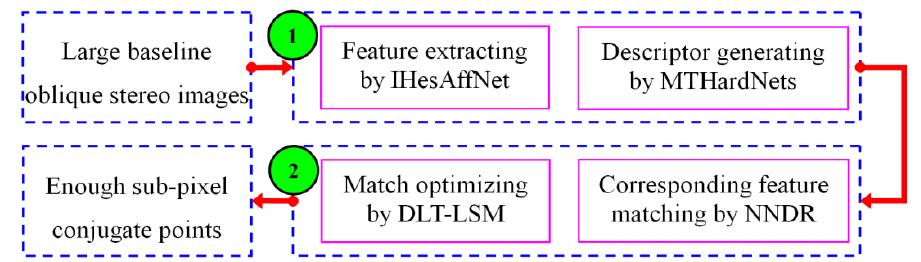
Figure 1. Flow chart of the proposed approach.